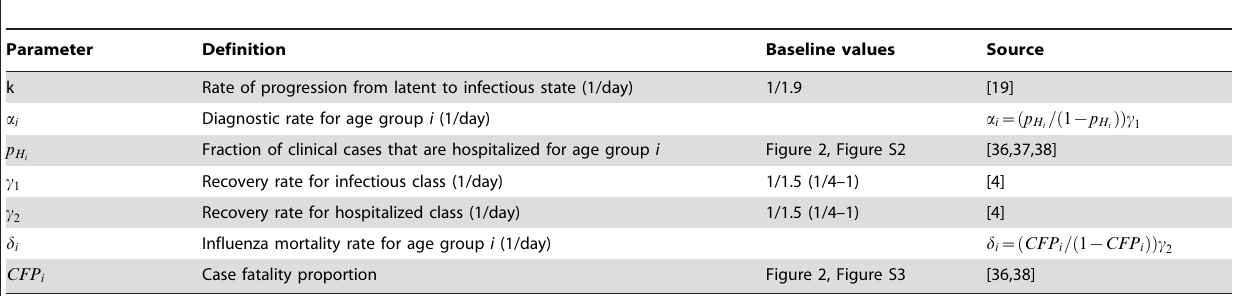
Table 1. Parameter definitions and mean baseline values of influenza epidemiology used in our transmission model.